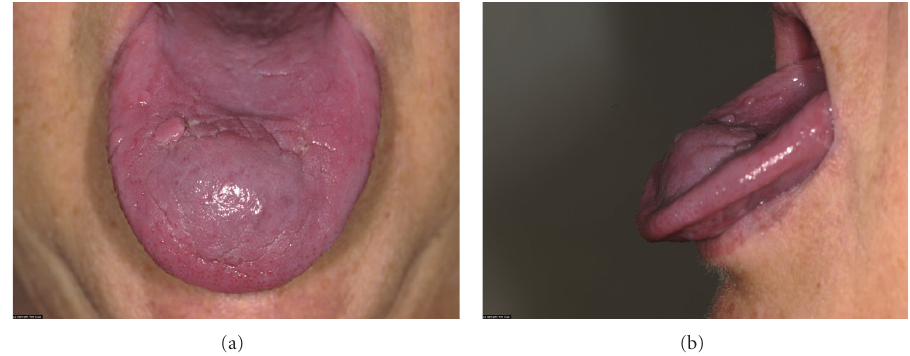
Figure 1: Tumour at first presentation. Painless, firm lump with no associated inflammation.